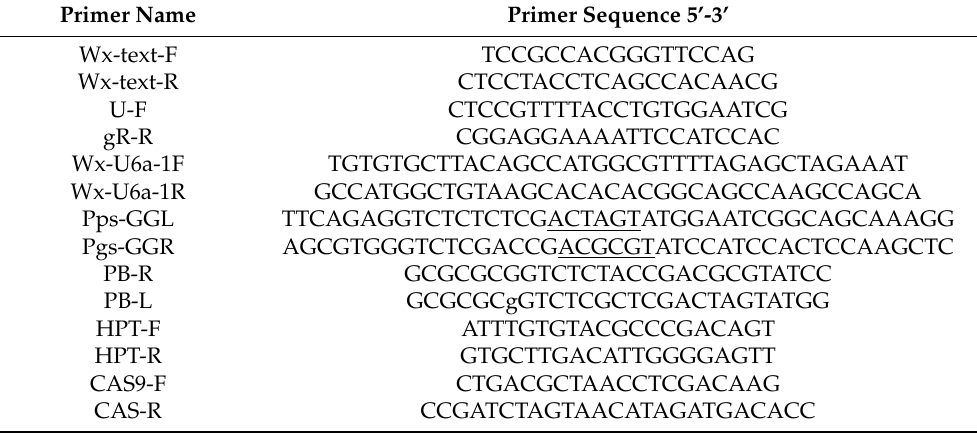
Table 1. Primer sequences used in this